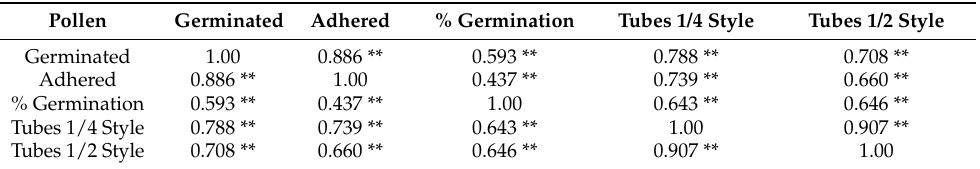
Figure 5. Percentage of avocado pollen germination on the stigma of different flower groups estab- lished based on fruit abscission data. Error bars are ± standard deviations. The same letter indicates no statistically significant differences at p < 0.05 (GLM analyses followed by Tukey HSD test). Table 2. Pearson correlation among the different avocado pollination parameters analyzed. ** Correlation is highly significant at p < 0.01.